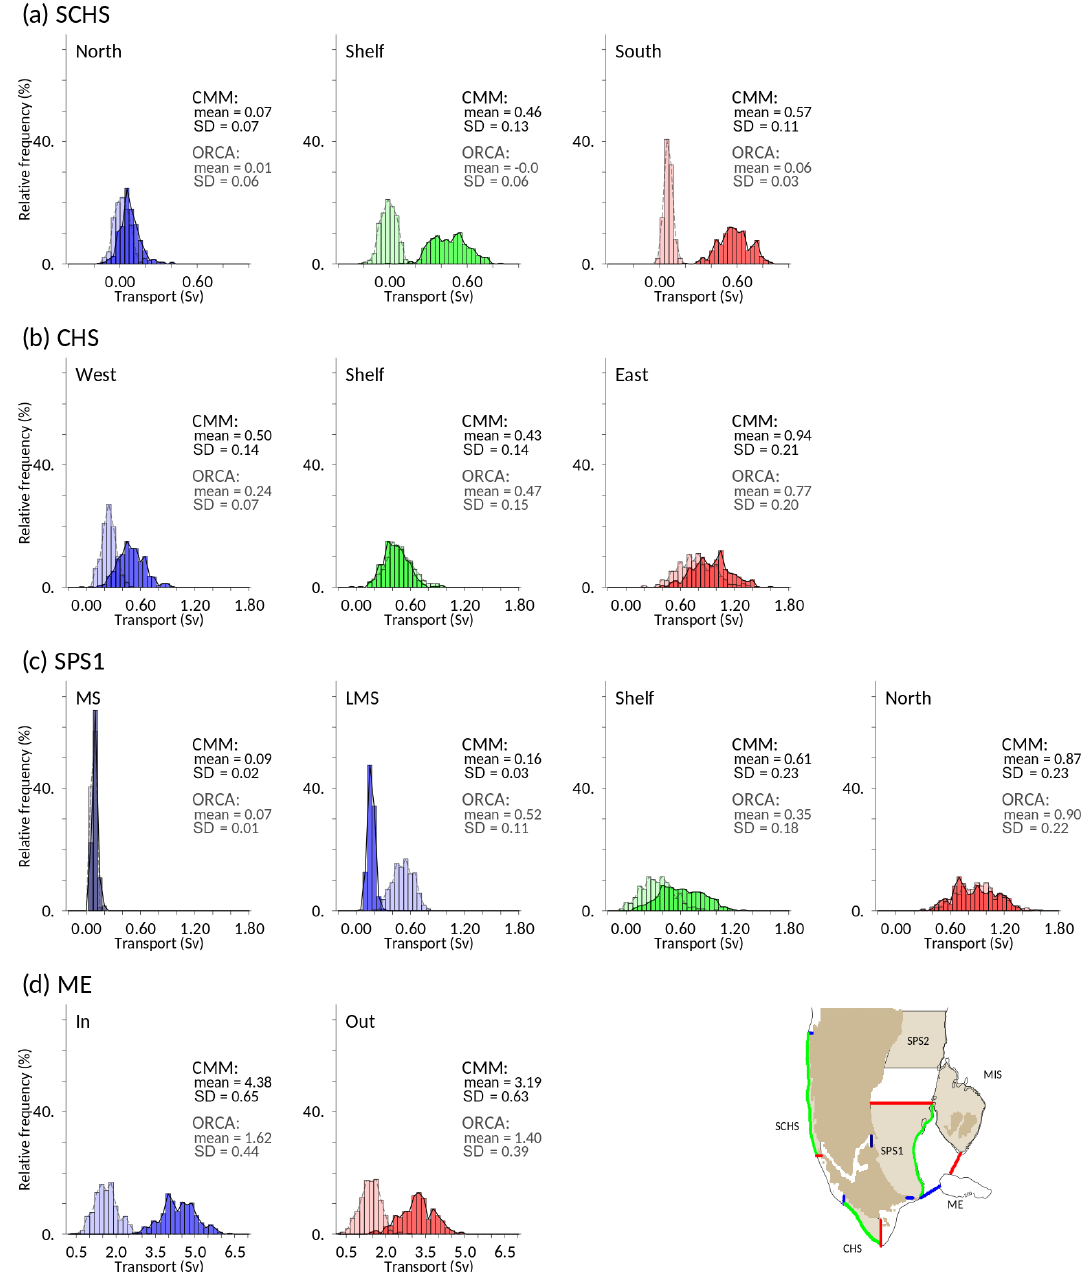
Figure 3. Histogram of transport over the 27 years at key locations of the SCHS (a) , the CHS (b) , the SPS1 (c) , and the Malvinas Embay- ment (d) , calculated along the colored sections indicated in the reference map. Opaque bins are from CMM, and transparent bins are from ORCA. The mean and standard deviation are indicated for each section. The transport is calculated over 200m for all sections except for the Malvinas Embayment sections, where it is computed throughout the water